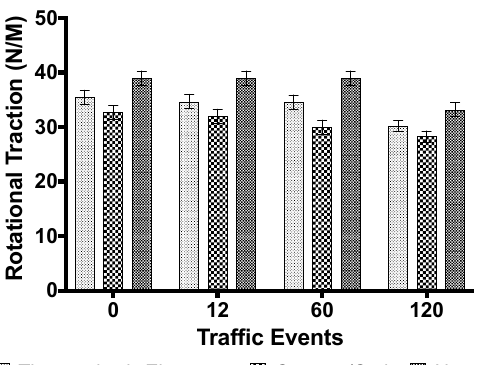
Figure 4. Rotational traction of three alternative infills was affected by the significant interaction of infill and games during 2017 in Knoxville, TN. Error bars represent standard error of the